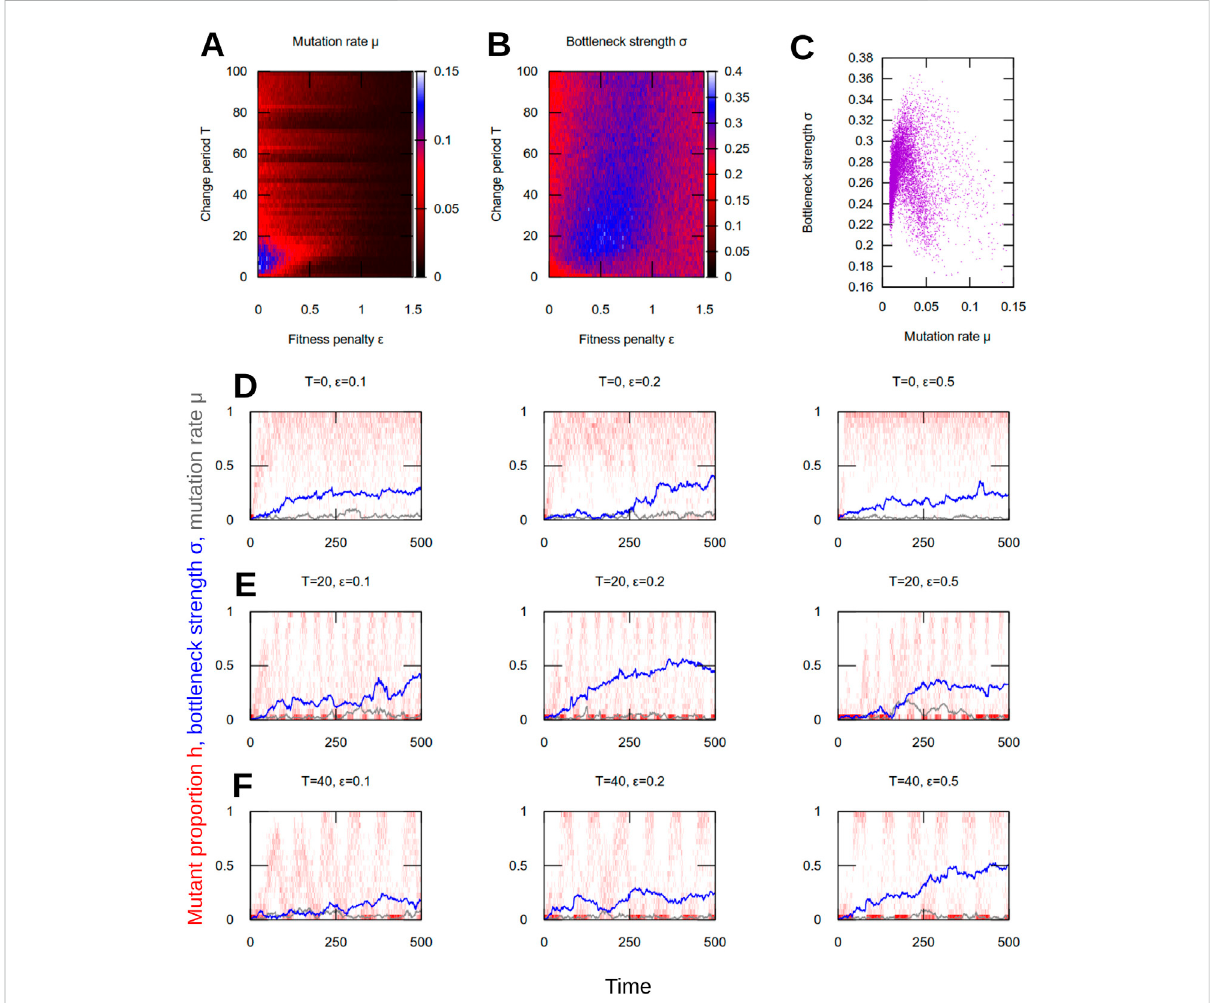
FIGURE 4 Evolution of mutation rate and segregation in dynamic environments. (A) Mean mutation rate μ , (B) mean segregation strength σ , and (C) joint mean μ and σ after t max = 500 generations in evolutionary simulations (see text). Each pixel value is the average over 100 simulation instances. Each point in (C) is from a particular parameterisation [i.e., a particular pixel in (A) and (B) ]. (D – F) Population histograms of mutant proportion h (red), plottedwithtracesofevolvingmeanmutationrate μ (grey)andsegregationstrength σ (blue),fordifferentparameterisationsandenvironmental changeregimes: (D) nochange; (E) rapidchange; (F) slowerchange. Resultsarefromsingle,representativesimulations,manyofwhich areaveraged to give the results in (A – C) . When environments change, mutation and segregation evolve together to facilitate adaptation (rapid shifting with environment) and robustness (high proportions of heteroplasmy). With higher fi tness penalties ϵ this behaviour takes longer to evolve but still